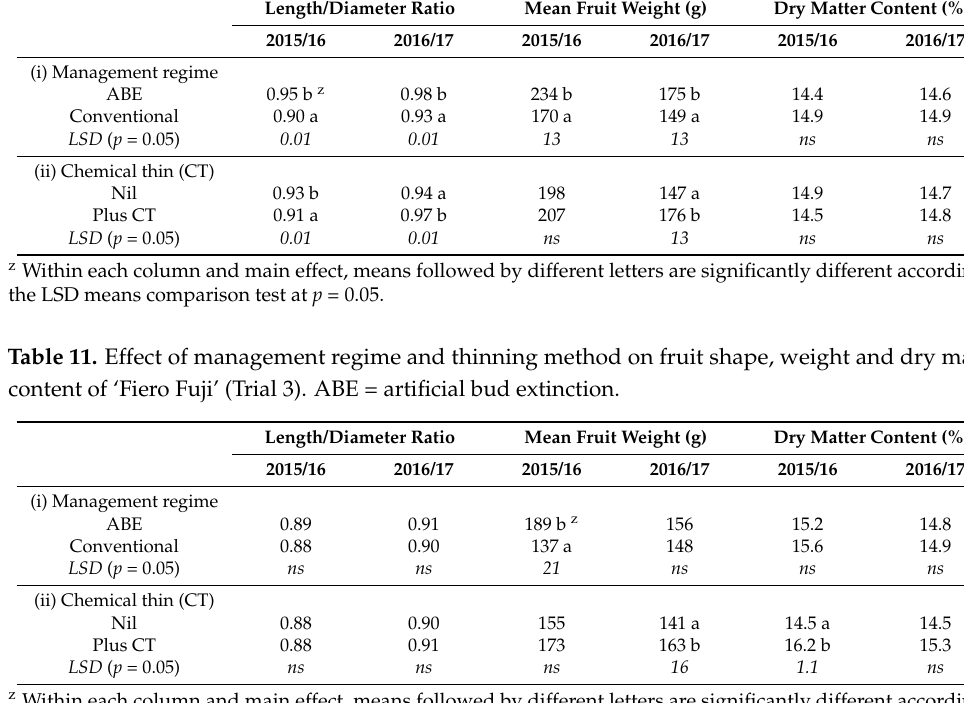
Table 10. Effect of management regime and thinning method on fruit shape, weight and dry matter content of ‘Alvina Gala’ (Trial 2). ABE = artificial bud extinction.